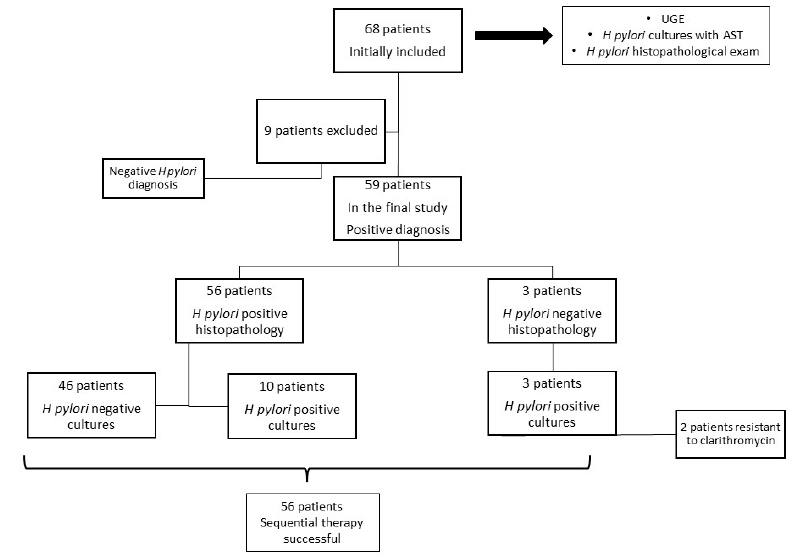
Figure 1. Flowchart of the selection of the patients included in the study. Abbreviations: UGE, upper gastrointestinal endoscopy; H. pylori, Helicobacter pylori; AST, antibiotic susceptibility testing.